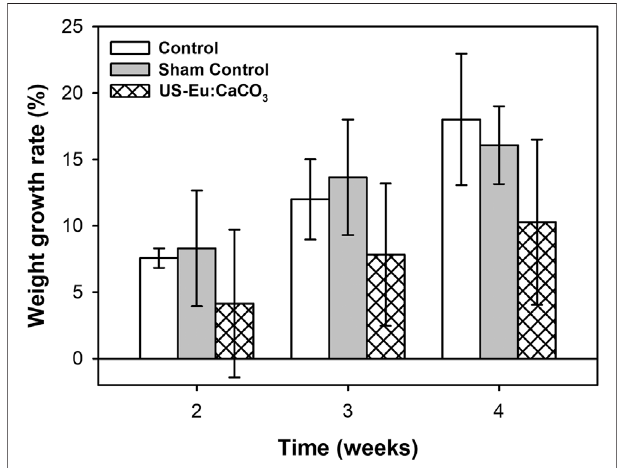
FIGURE 11 | The growth rate of waistline in SD rats after treated with CaCO 3 : Eu injection and ultrasound